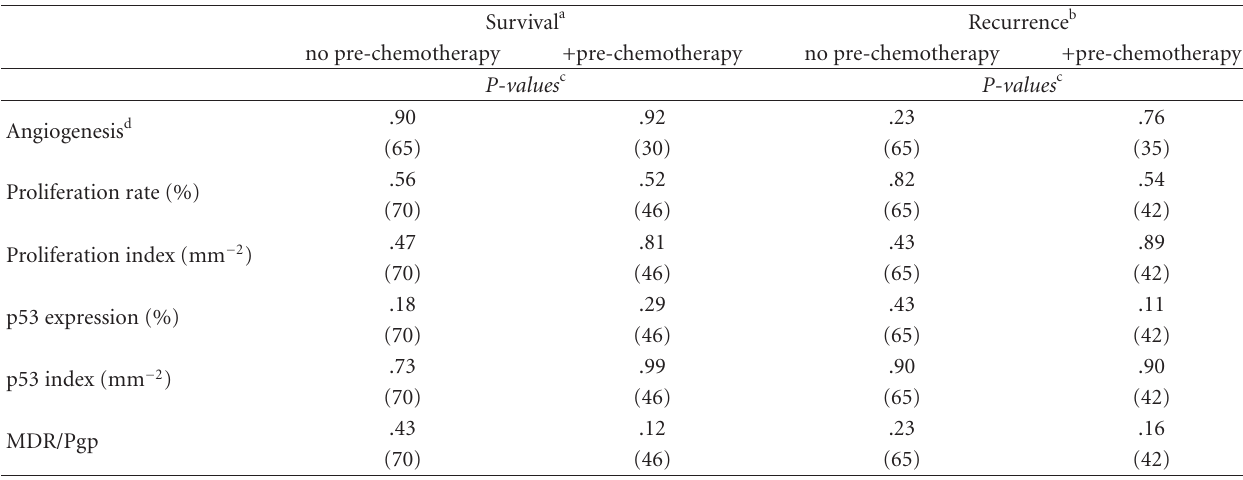
a Analysis based on disease-specific mortality, and for continuous parameters divided on the median, whereas for MDR/Pgp divided in a chemotherapy- sensitive group (score < 2) and a chemotherapy-resistant group (score ≥